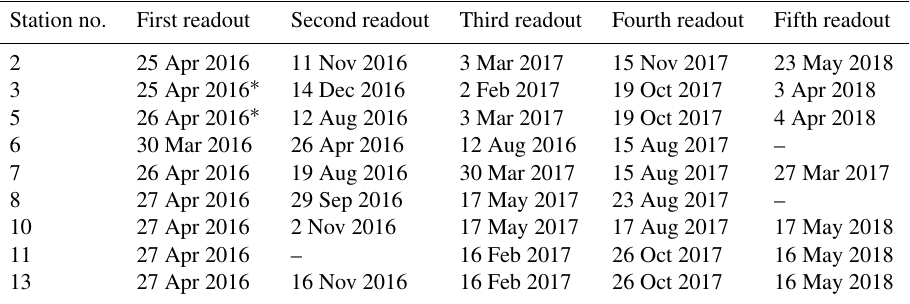
Table 3. Readout dates of self-contained data loggers at the respective stations. Asterisk indicates when only loggers for dissolved oxygen concentration were read out. Station no. First